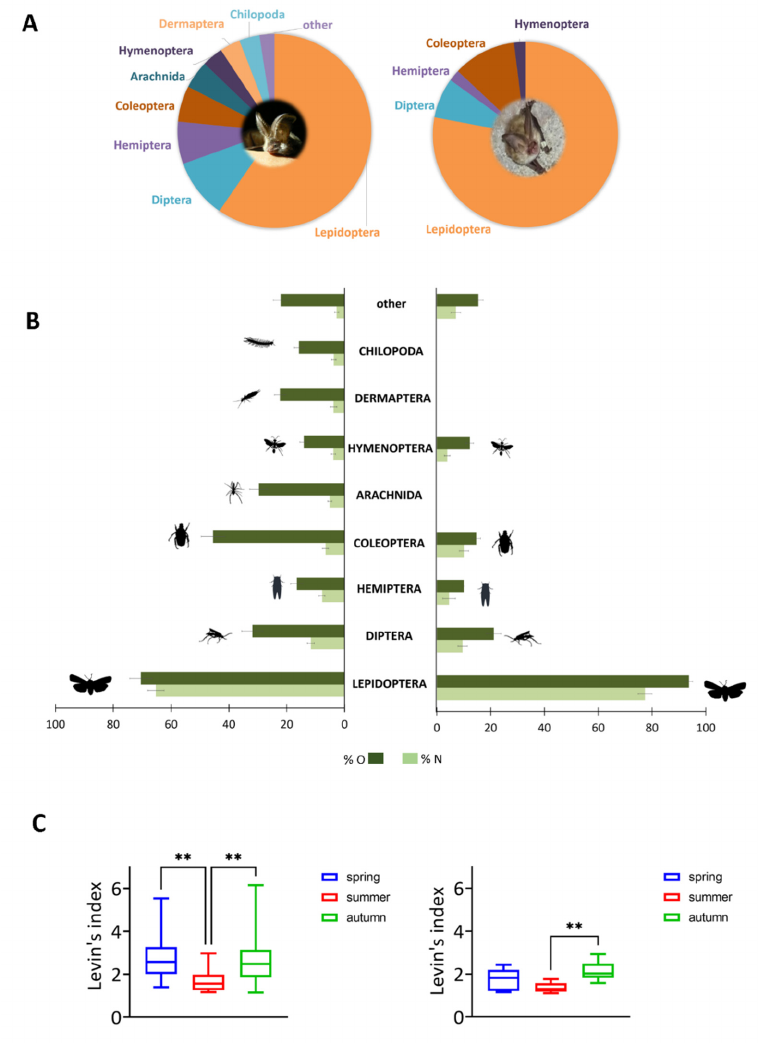
Figure 6. Reconstruction of prey spectra of P. auritus (left) and P. austriacus (right). ( A ) Mean volume proportion of prey items at the ordinal level. ( B ) Mean frequency of occurrence (%O) and numerical abundance (%N) of prey items (mean ± SD) at the ordinal level determined by microscopic fecal analysis. ( C ) Seasonal changes of Levins’ trophic niche breadth index B. Significant differences between seasons are indicated by asterisks (** p ≤ 0.005). P. auritus: n = 430 pellets, P. austriacus: n = 240 pellets.